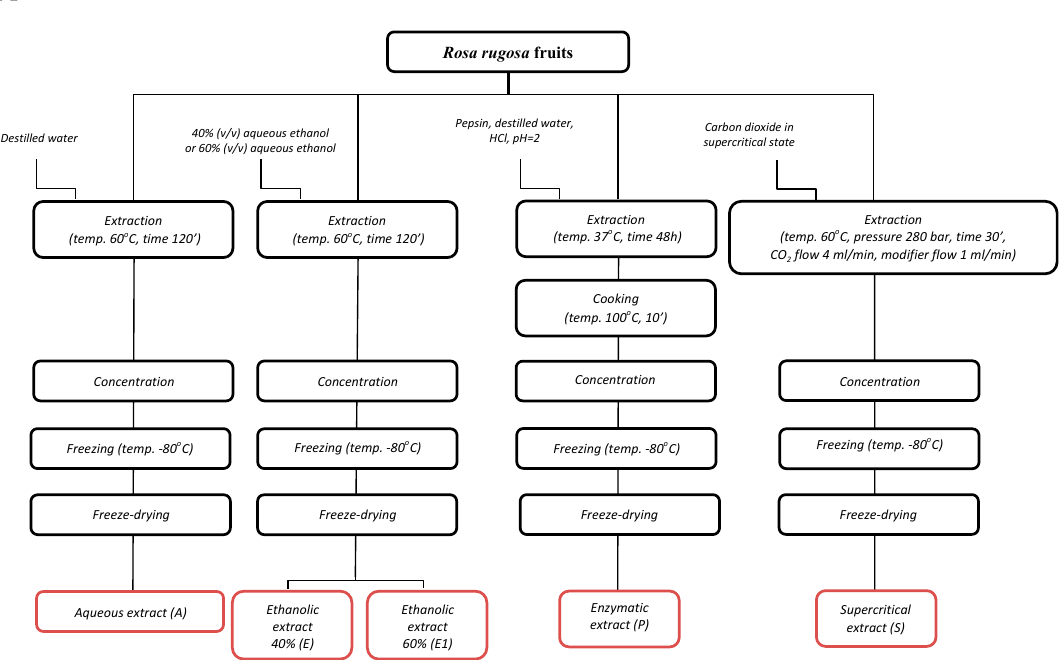
Figure A1. The scheme for preparing extracts from Rosa rugosa fruits.